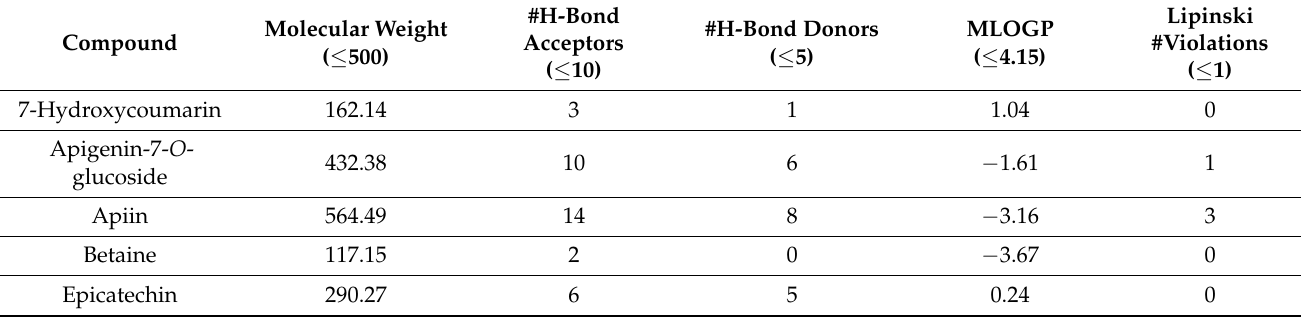
Table 5. Physicochemical properties of TLE phytochemical compounds based on Lipinski’s rule of five parameters.